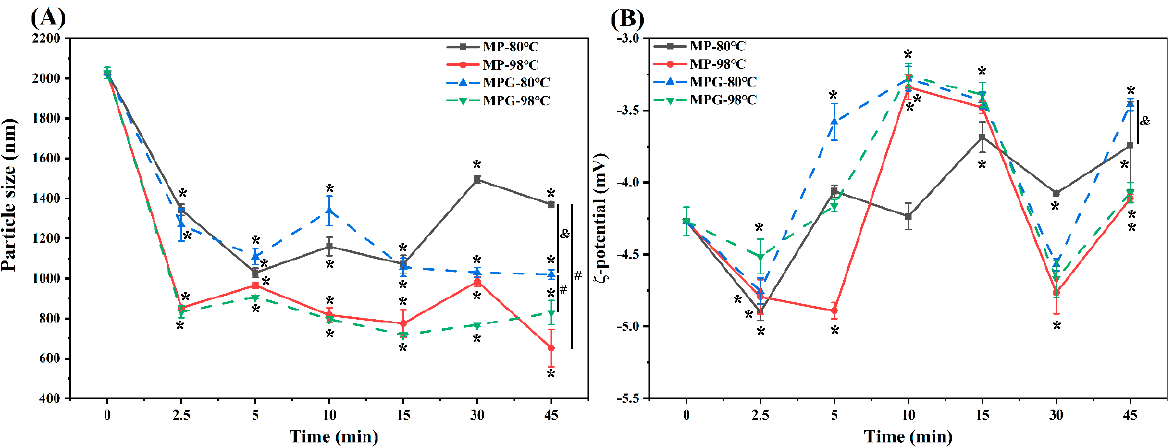
Figure 8. Changes in particle size ( A ) and ζ -potential ( B ) of myofibrillar protein and glucose (MPG) and myofibrillar protein (MP) under different heating conditions (80 °C and 98 °C, 0 − 45 min). Error bars indicate standard deviation (n = 3). Samples with * p < 0.05 indicate significant differences at different heating times (compared with 0 min). Samples with # p < 0.05 indicate significant differences between 80 °C and 98 °C. Samples with & p < 0.05 indicate significant differences between MPG and MP.